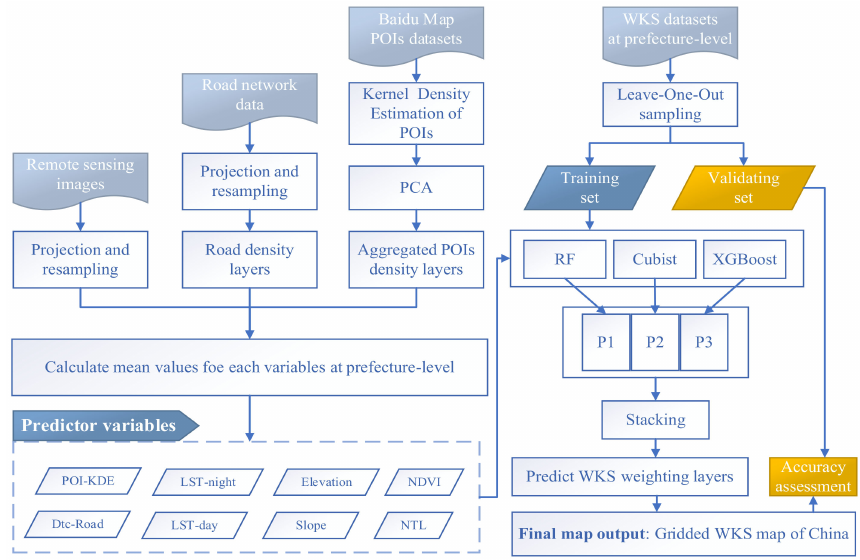
Figure 1. Flowchart of the proposed methodology for WKS